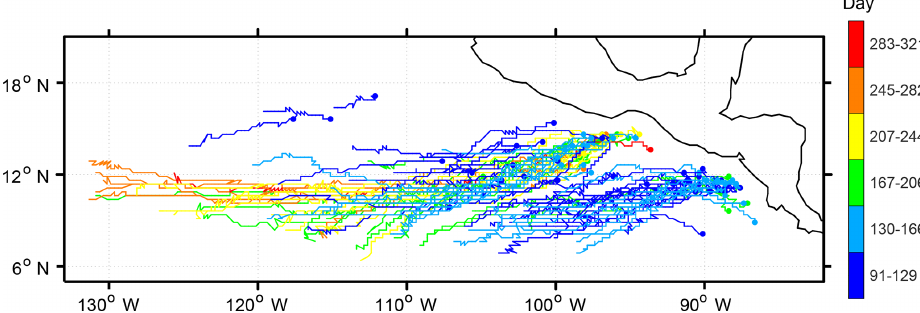
Figure 7. Trajectories of long-lived anticyclonic eddies (ACEs) with a lifetime equal to or longer than 90d during the time interval from 1993 to 2016. The lifetimes of detected eddies are divided into six classes. Tracks of eddies are shown in colors corresponding to each lifetime class.